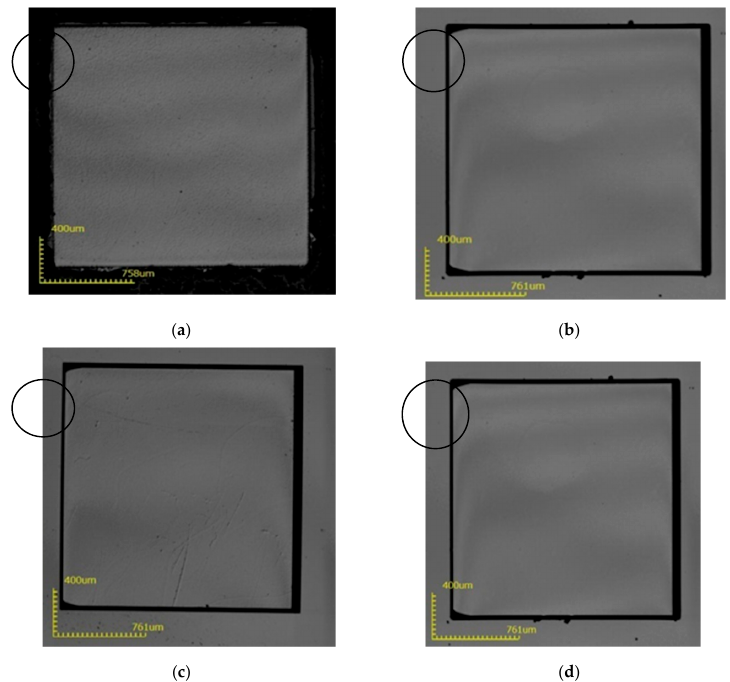
Figure 6. The surface state of the substrate after removing the mask layer after etching at 275 °C ; ( a ) 1-3#; ( b ) 2-3#; ( c ) 3-3#; ( d ) 4-3# It can be seen from Figure 7 that at 300 °C, the mask area of sample 1# is completely corroded, the thickness of the mask layer of samples 2# and 4# are not enough, causing part of the mask area surface to be corroded, and the mask area of sample 3# is completely protected. At 300 °C , the corrosion depth can reach 72 μ m, as seen in Table 5.